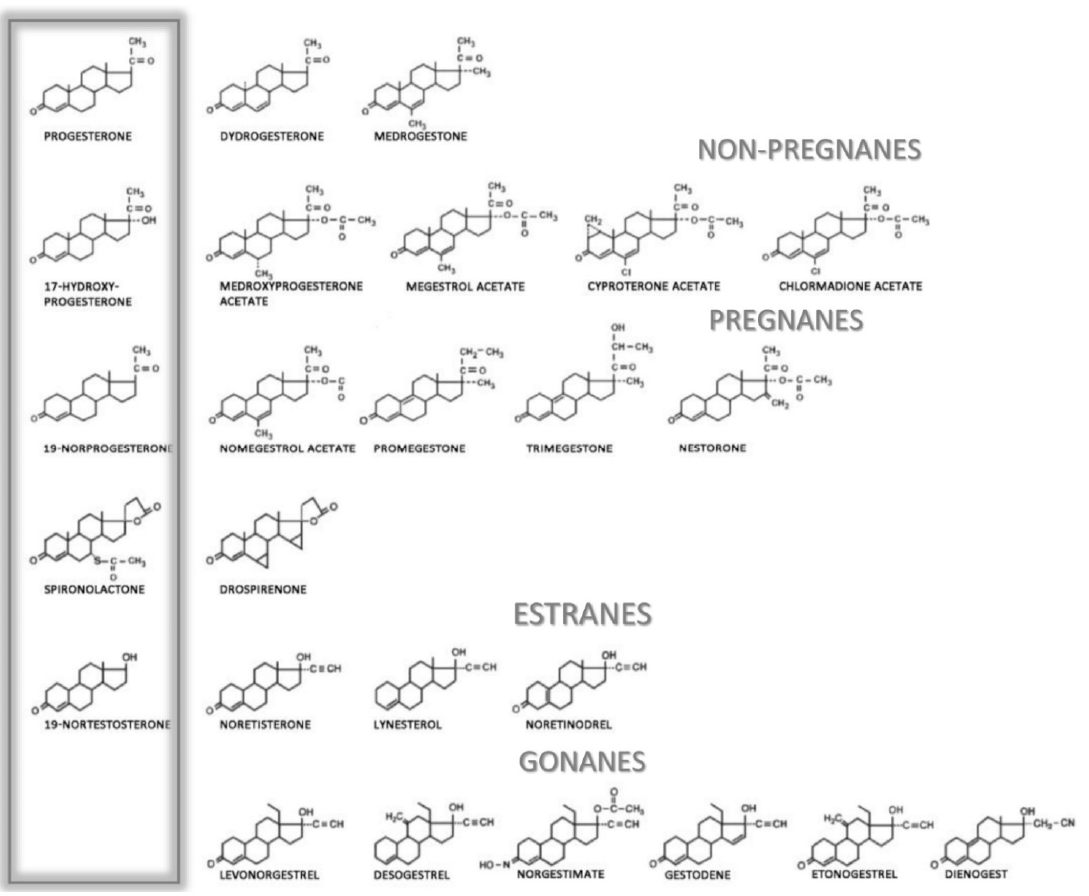
Figure 5. Chemical structures of progestagens used in human